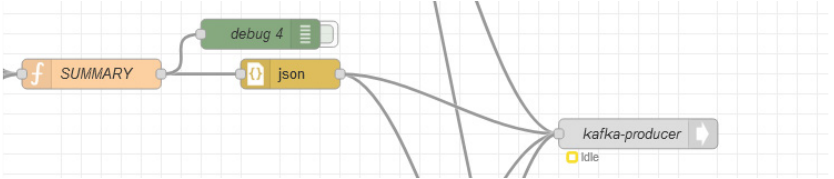
Figure 16. Final flow of the Node-Red API, presenting the node “kafka-producer”, used to send the information back to Apache Kafka.